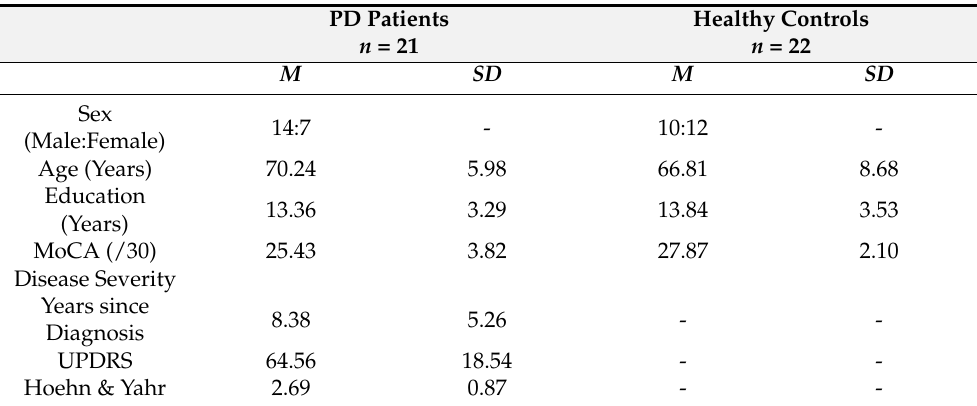
Table 1. Demographics for Parkinson’s disease (PD) Patients and Healthy Controls (means and standard